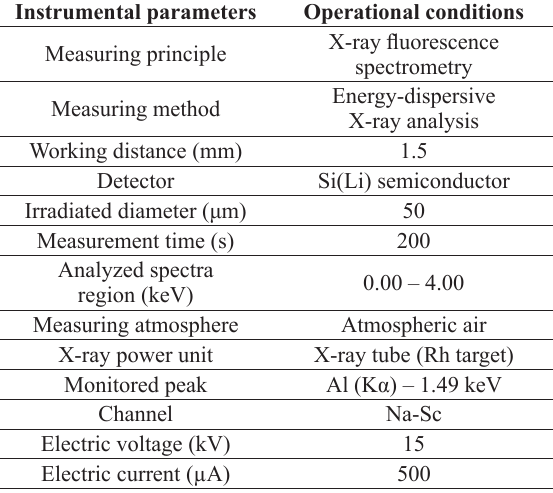
Operational conditions in μ-EDX Instrumental parameters